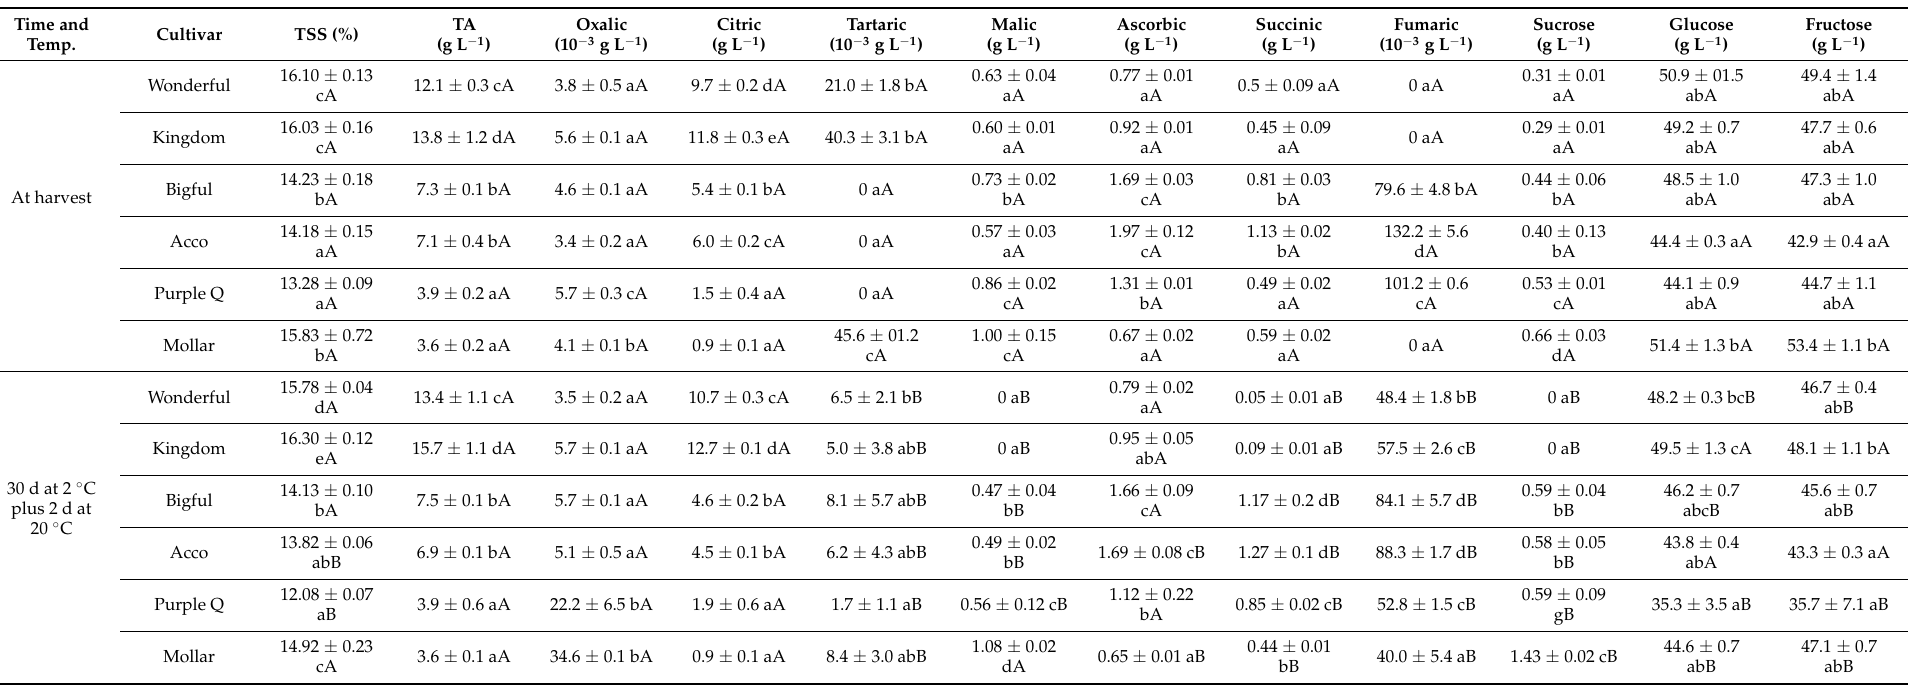
Table 4. Total soluble solids, titratable acidity (TA), organic acid and sugar contents in aril juice of different pomegranate cultivars. Time and